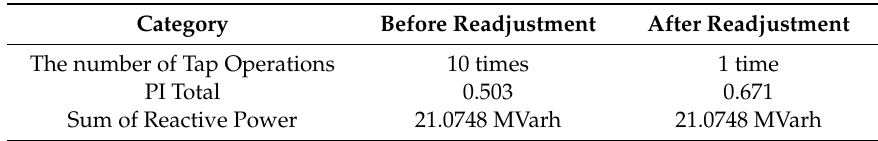
Figure 24. Reactive power reference of case 1 for nominal voltage. Table 7. Comparison of the number of tap operations, PI total, sum of reactive power with/without proposed schedule method of case 1 for nominal voltage.